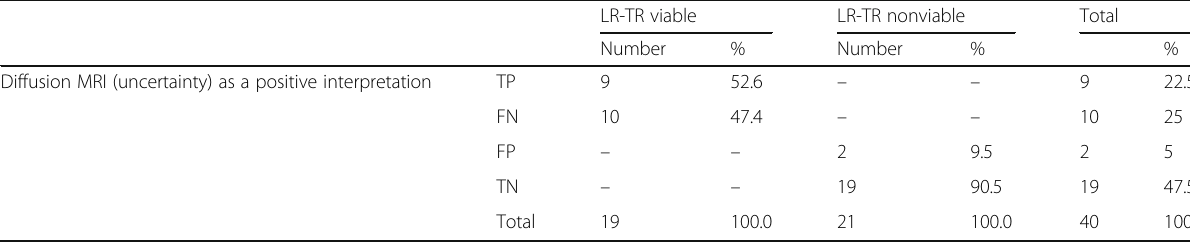
Table 4 Correlating diffusion MRI results to the final diagnosis in the studied group